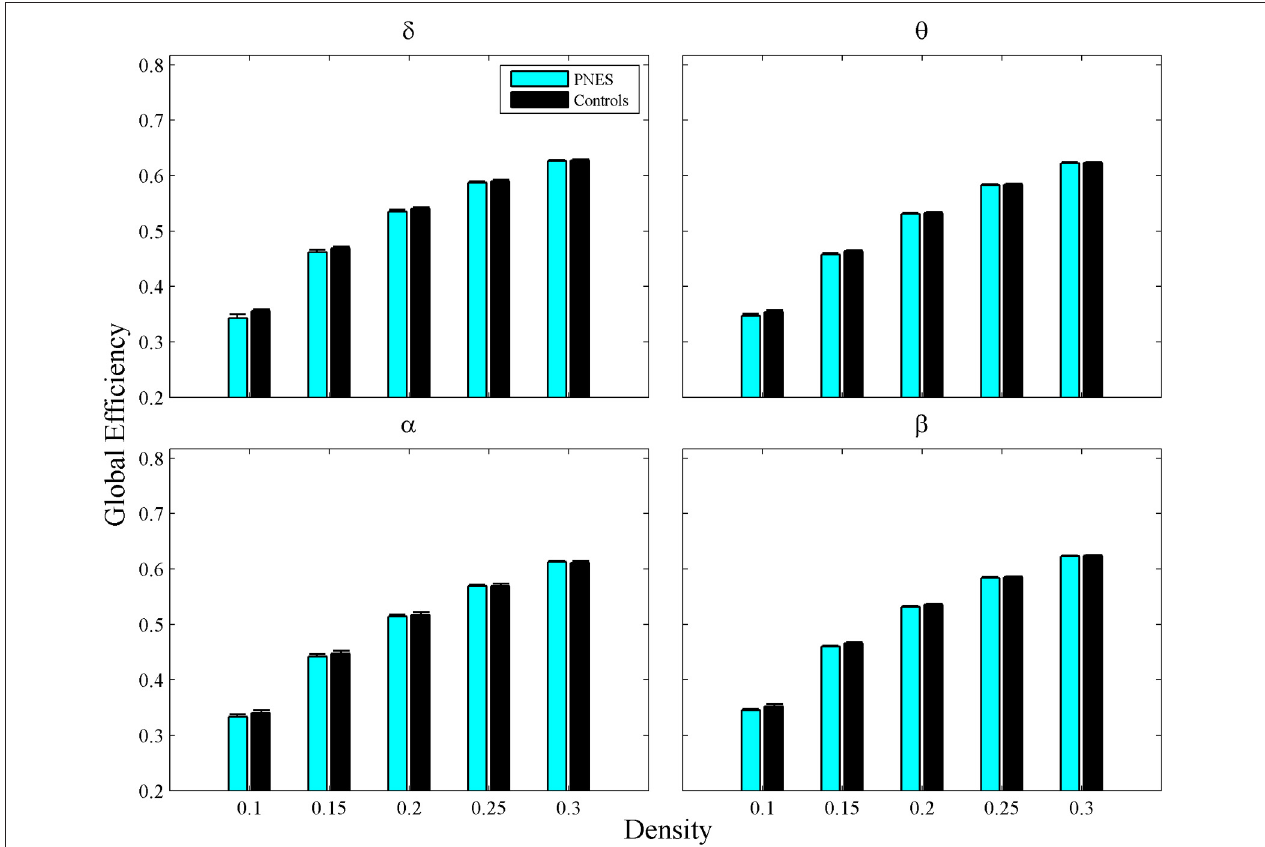
FIGURE A2 | Global Efficiency as a function of network density for PNES and controls. The plots show the global efficiency of functional brain networks as a function of density in PNES patients and controls. Other designations are as Figure 2